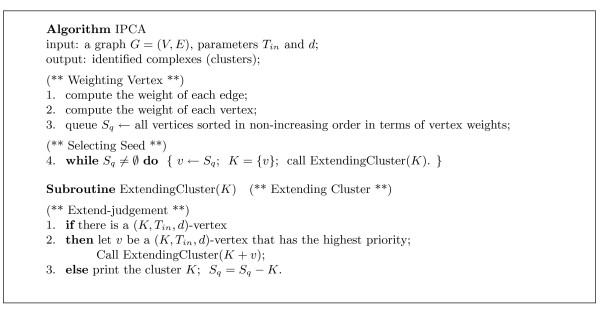
The description of IPCA algorithm. IPCA algorithm extends clusters based on (K, Tin, d)-vertices. If the algorithm uses the (SP ≤ d)-Version in the conditions of Definition 1, we will say that "the algorithm uses SP ≤ d". Similarly, if the algorithm uses the (ASP ≤ d)-Version in the conditions of Definition 1, we will say that "the algorithm uses ASP ≤ d".